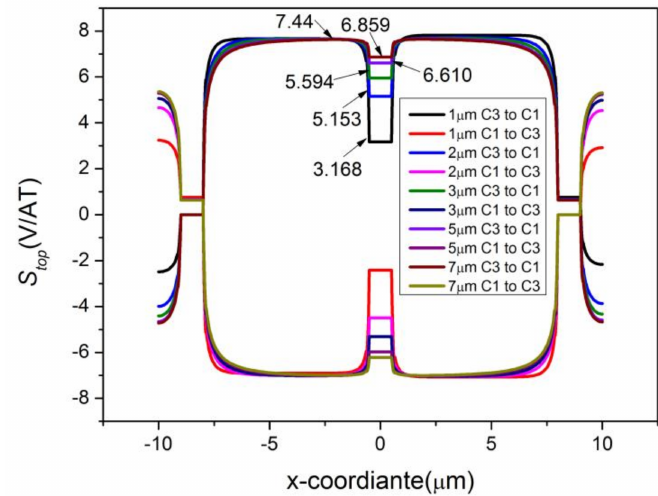
Figure 9. Comparisons between different depths of the active region in S top . The depth changes from 1 µ m to 7 µ m.